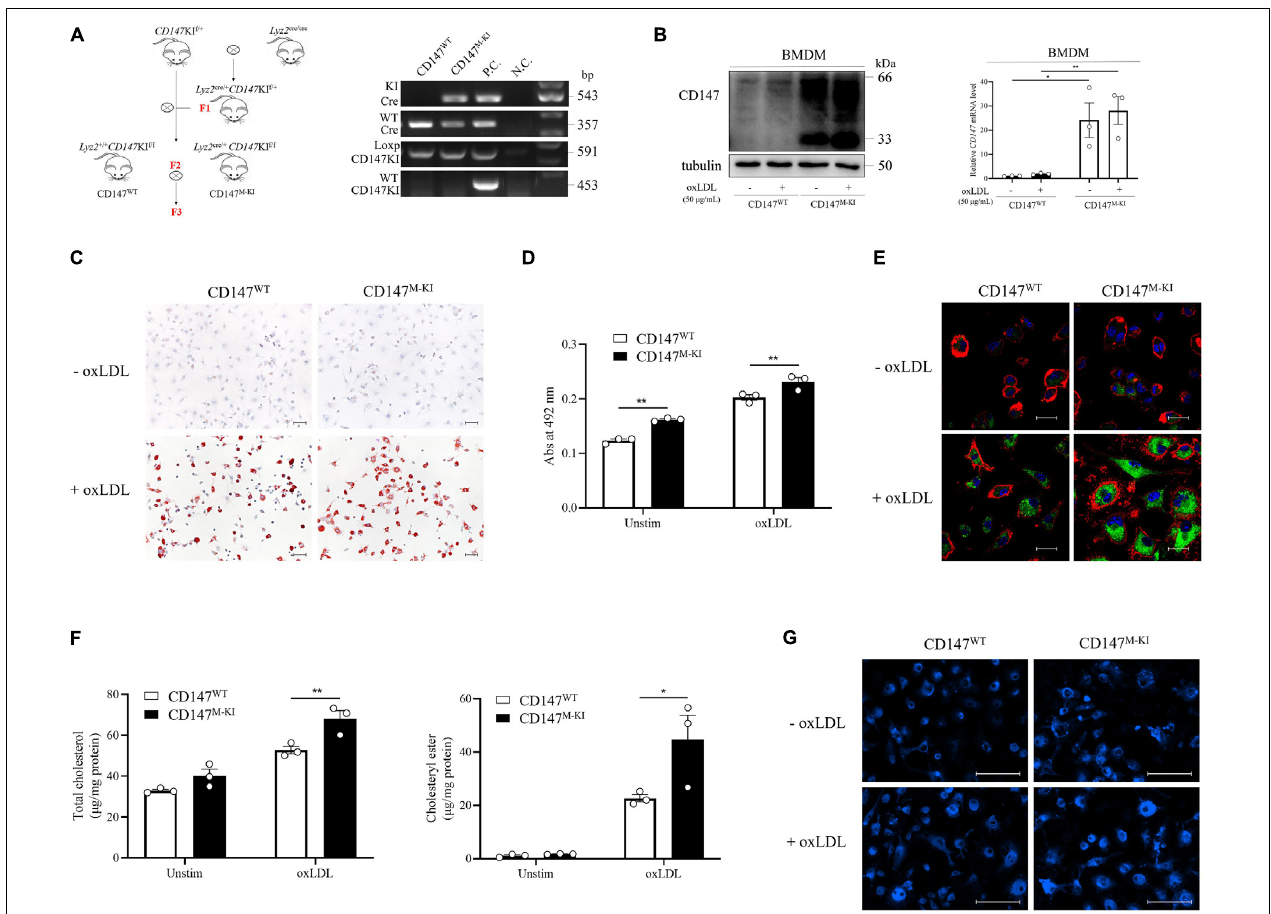
FIGURE 5 | Macrophage-specific CD147 knockin promotes foam cell formation. (A) Generation of macrophage-specific CD147 knockin mice ( Lyz2 cre / + CD147 KI f / f , namely, CD147 M − KI mice) is illustrated by the mating scheme. The control WT littermates were Lyz2 + / + CD147 KI f / f , namely, CD147 WT mice. PCR analysis of genomic DNA showed the genotyping. The fragments from top to bottom are the KI Cre gene, WT Cre gene, floxed CD147 KI gene and WT CD147 KI gene. Genomic DNA from Lyz2 cre / + mice was used as the P.C. for Cre analysis. Genomic DNA from CD147 KI f / + mice were used as the P.C. for CD147 analysis. H 2 O was used as the N.C. (B) Characterization via western blotting and RT-PCR of BMDMs with or without ox-LDL treatment isolated from CD147 WT or CD147 M − KI mice. (C) Representative images of Oil Red O staining of CD147 WT or CD147 M − KI BMDMs that were incubated with or without ox-LDL (50 µ g/mL) for 24 h. The scale bar is 50 µ m. (D) For quantification, Oil Red O absorbance was measured at 492 nm after extraction with isopropanol. (E) BMDMs from CD147 WT or CD147 M − KI mice stimulated with or without ox-LDL (50 µ g/mL) for 24 h were stained with Bodipy (lipids, green), F4/80 (macrophages, red), and DAPI (nuclei, blue) and examined via confocal microscopy. The scale bar is 20 µ m. (F) The total cholesterol and cholesteryl ester contents were determined with a coupled enzyme assay. (G) Representative images of Filipin staining of BMDMs from CD147 WT or CD147 M − KI mice treated with or without ox-LDL (50 µ g/mL) for 24 h. The scale bar is 100 µ m. Data represent the mean ± SEM. of n = 3 biologically independent experiments. * P < 0.05, ** P < 0.01.